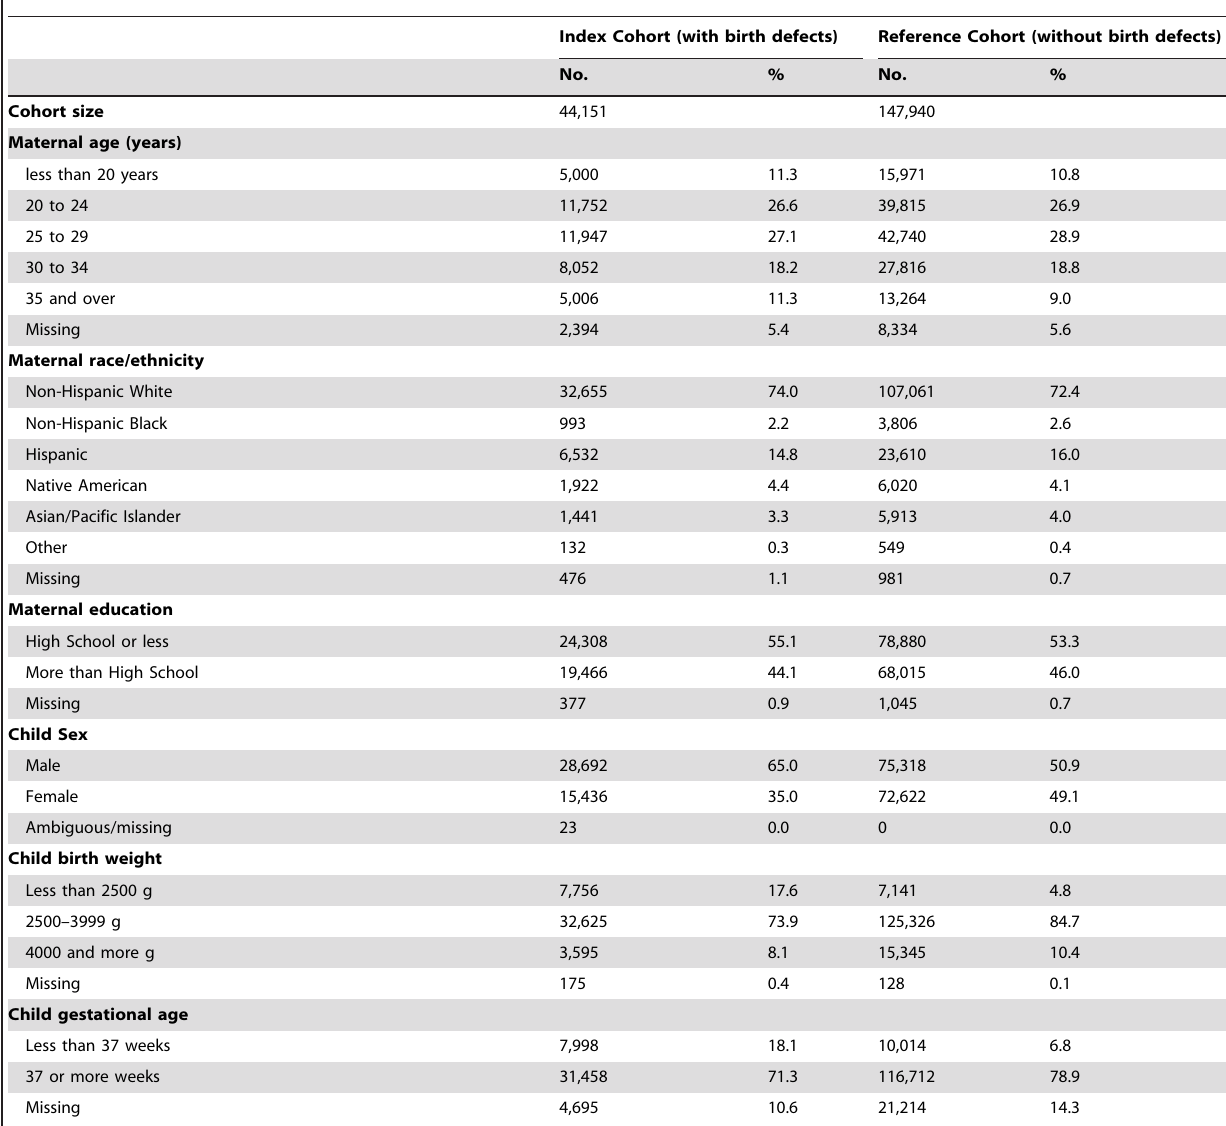
Table 2. Maternal and child characteristics in index and reference cohorts, UTAZIA